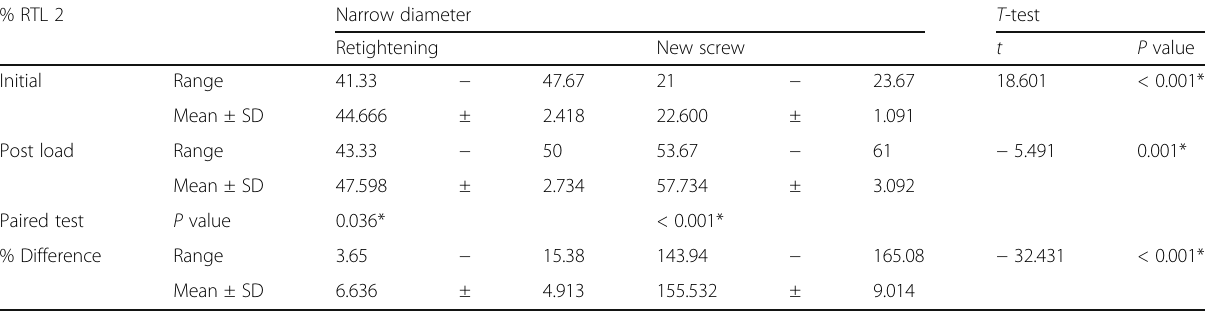
Table 6 Mean ± SD of percentage initial and percentage post load RTL 2 and percentage difference between initial and post load RTL 2 for GIIA and GIIB % RTL